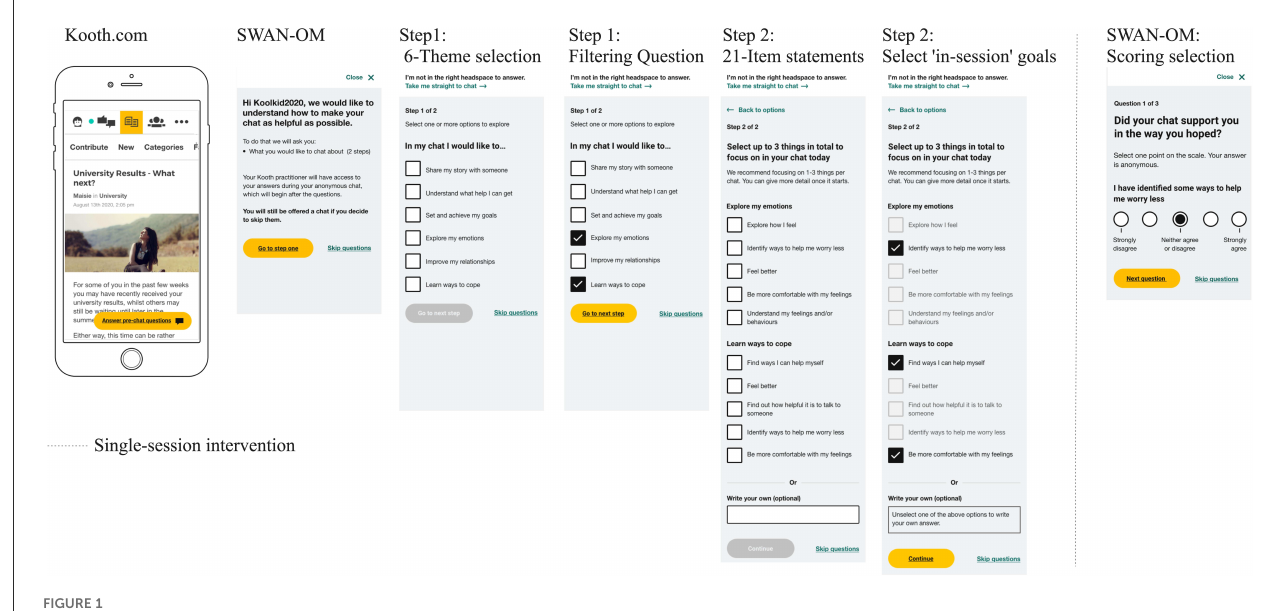
FIGURE1 Smartphone wireframes of SWAN-OM at